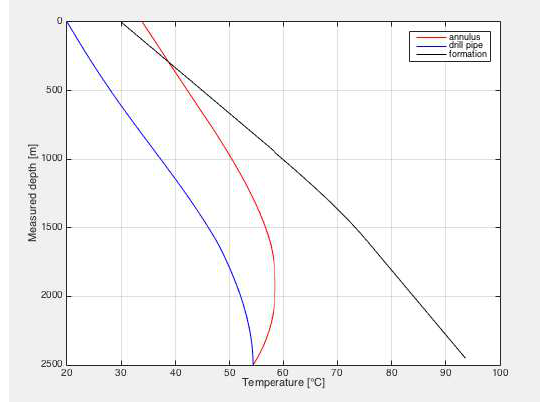
Figure 6: Temperature distribution( c p = 2000 J/kg ◦ C)